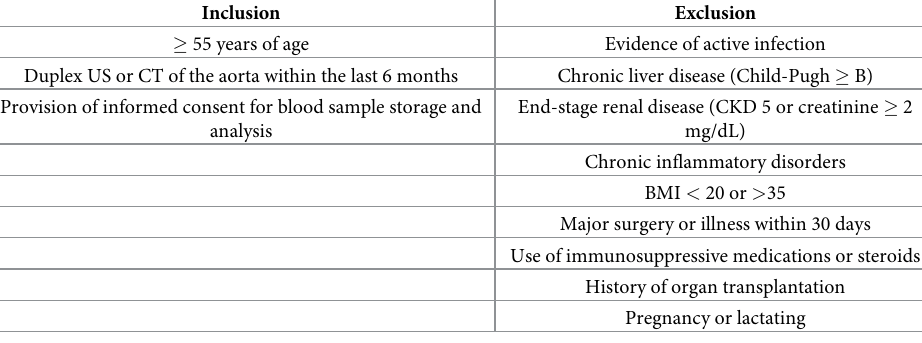
Table 1. Study inclusion and exclusion